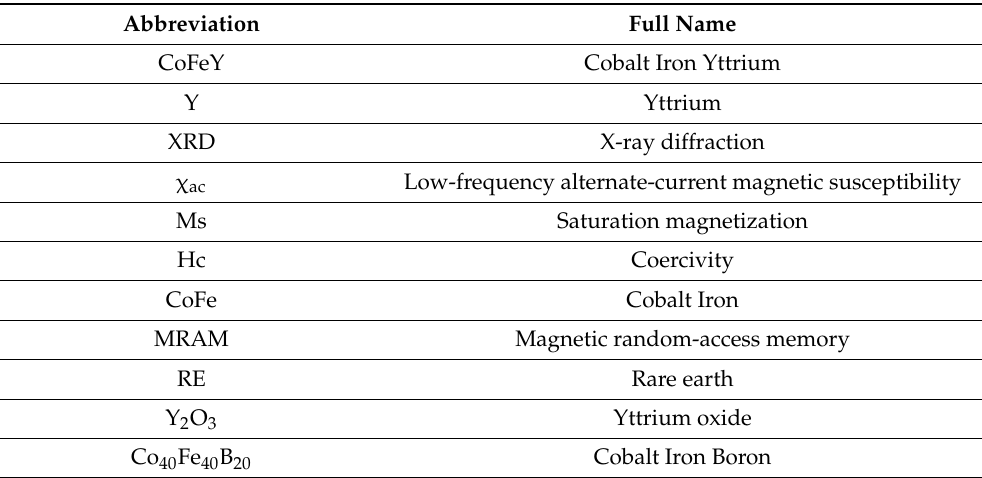
Table 1. Names of proper nouns in full and abbreviated